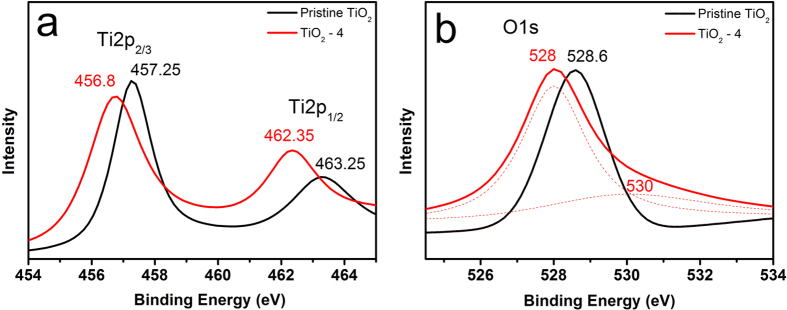
X-ray photoelectron spectra (XPS) of (a) Ti2p and (b) O1s of pristine TiO2 and TiO2-4.